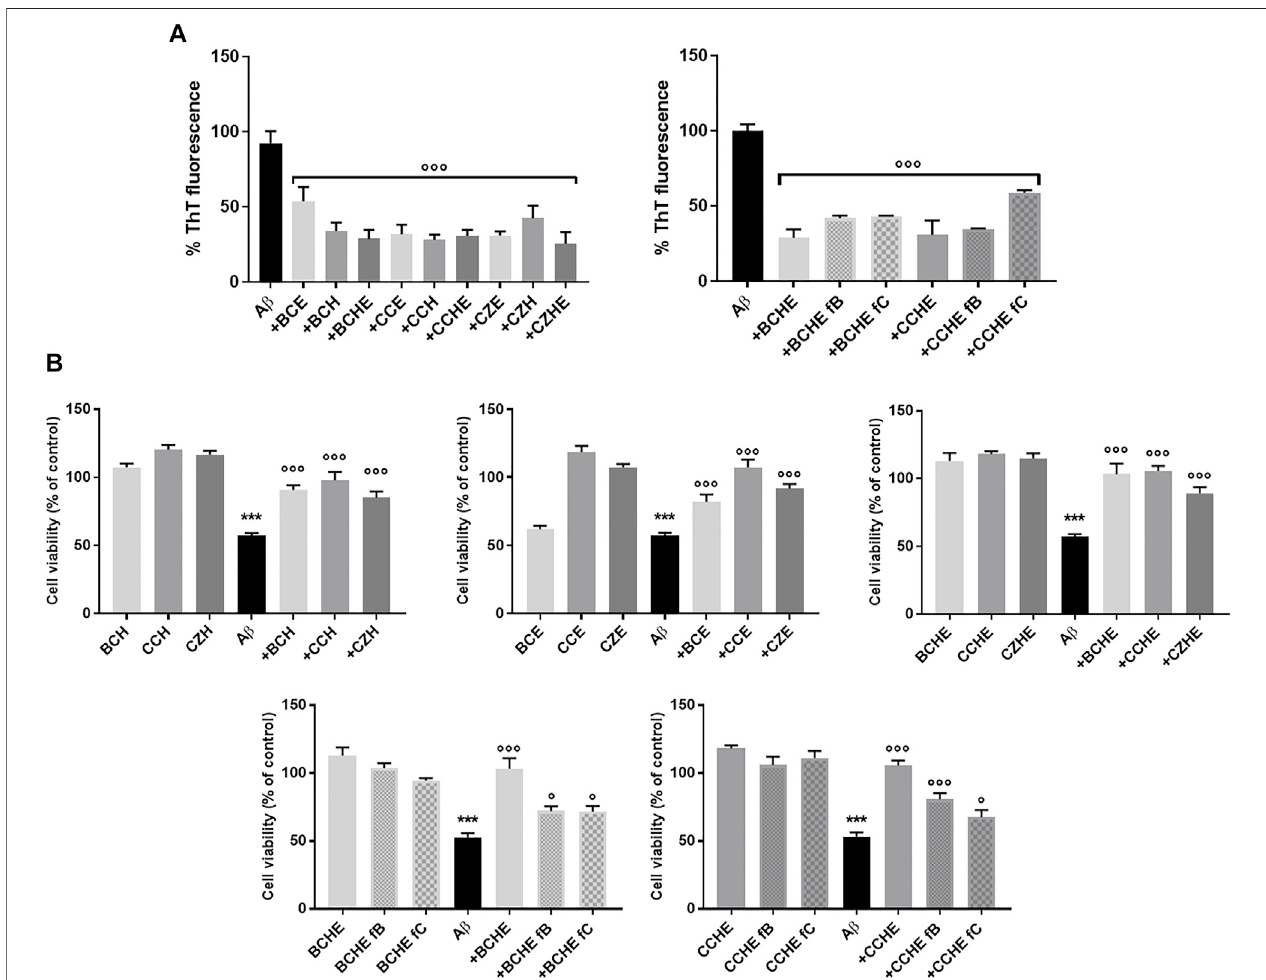
FIGURE3| EffectsofcinnamonextractsandfractionsonA β 1-42aggregationandoligomerstoxicityonthehumanneuroblastomaSH-SY5Ycellline. (A) Theeffect ofincubation(24 hat37 ° C)ofBC,CC,andCZextracts(2.5 μ g/ml)andBCHEorCCHEfractionsBandC(2.5 μ g/ml)onA β 1-42(2.5 μ M)aggregationwasdeterminedby ThT fl uorescence assay. Values are the mean ± standard deviation of three replicates after subtracting their relative control solutions (extracts alone). *** p < 0.001 vs. A β 1-42 alone. Dunnett ’ s multiple comparisons test followed one-way ANOVA. (B) Cells were treated with A β 1-42 peptide (10 μ M) and incubated with or without 10 μ g/ml of BC, CC, and CD extracts or BCHE and CCHE fractions B and C for 24 h, and the toxicity was evaluated by MTT assay. Values are the mean ± standard deviationofthreereplicates.One-wayANOVAfollowedbyDunnett ’ smultiplecomparisontest:*** p < 0.001vs.vehicle,* p < 0.05and*** p < 0.001vs.A β